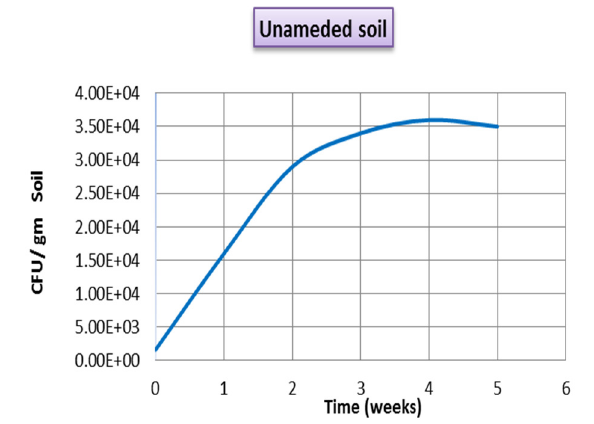
Fig. 6. Changes in counting of diesel-utilizing bacteria for unamended soil